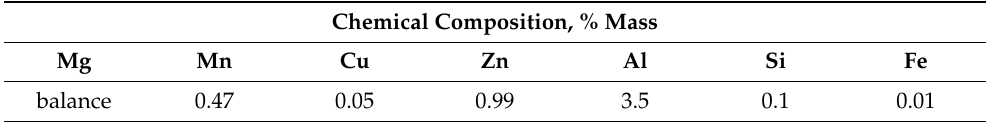
Table 1. Chemical composition of the AZ31material used for the tests.